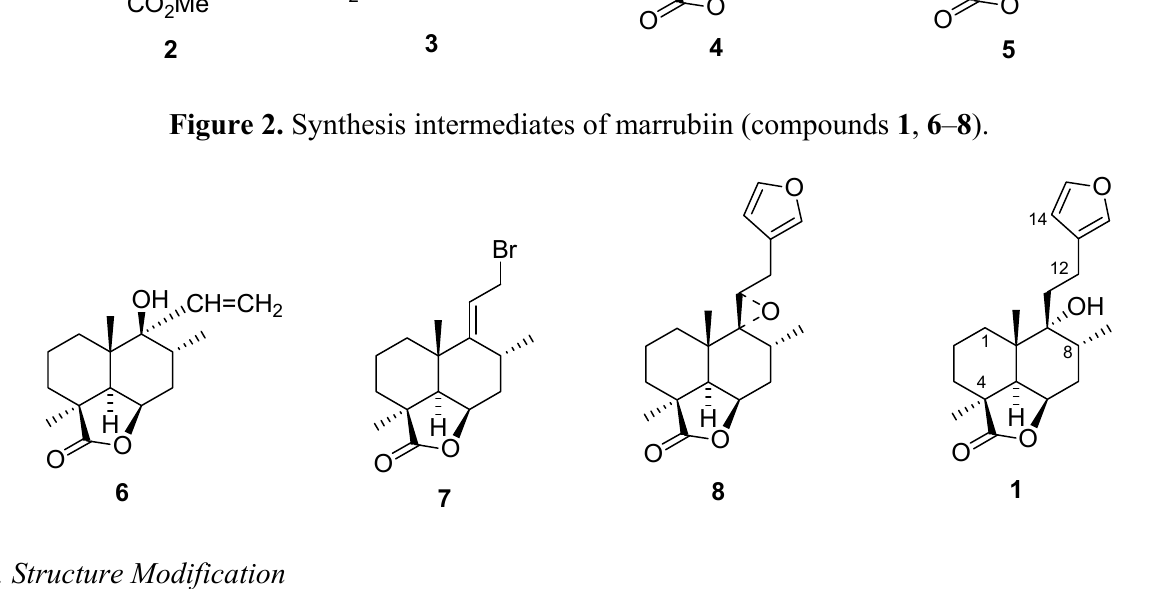
Figure 2. Synthesis intermediates of marrubiin (compounds 1 , 6 – 8